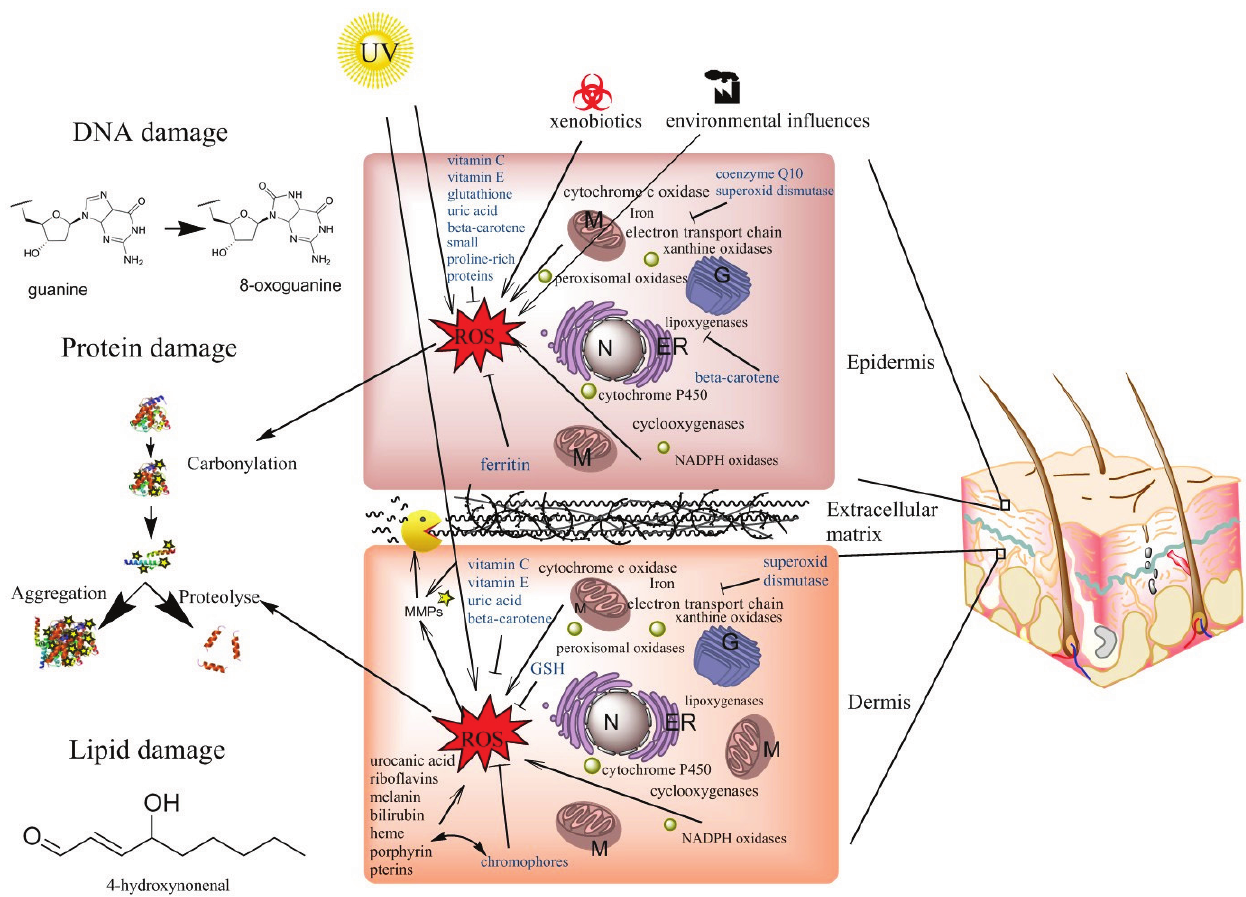
Figure 1. Schematic of the interplay between different ROS sources and the anti-oxidative systems in the skin. All ROS sources discussed in this manuscript are exemplified in black letters: cytochrome c oxidase, ETC (electron transport chain), iron ions, xanthine oxidase, peroxisomal oxidases, lipoxygenases, cytochrome P450, cyclooxygenases, NADPH oxidases, UV-radiation, xenobiotics and several chromophores that lead to ROS. Examples of anti-oxidative systems are given in blue letters: vitamin C and E, GSH (glutathione), GSH peroxidases, uric acid, beta-carotene, the SPRR2 (small proline rich repeat) family, SOD (superoxide dismutase), CoQ10 (coenzyme Q) and ferritin. Generally it has to be stated that only the SPRR2 proteins are specific for the epidermis, but the concentration of most anti-oxidants is much higher in the epidermis than in the dermis. Possible outcomes of oxidative damage to the cells (damage to DNA, proteins and lipids) are shown on the left-hand side of the figure. (M) stands for mitochondria, (ER) for endoplasmic reticulum, (N) for nucleus and (G) for Golgi